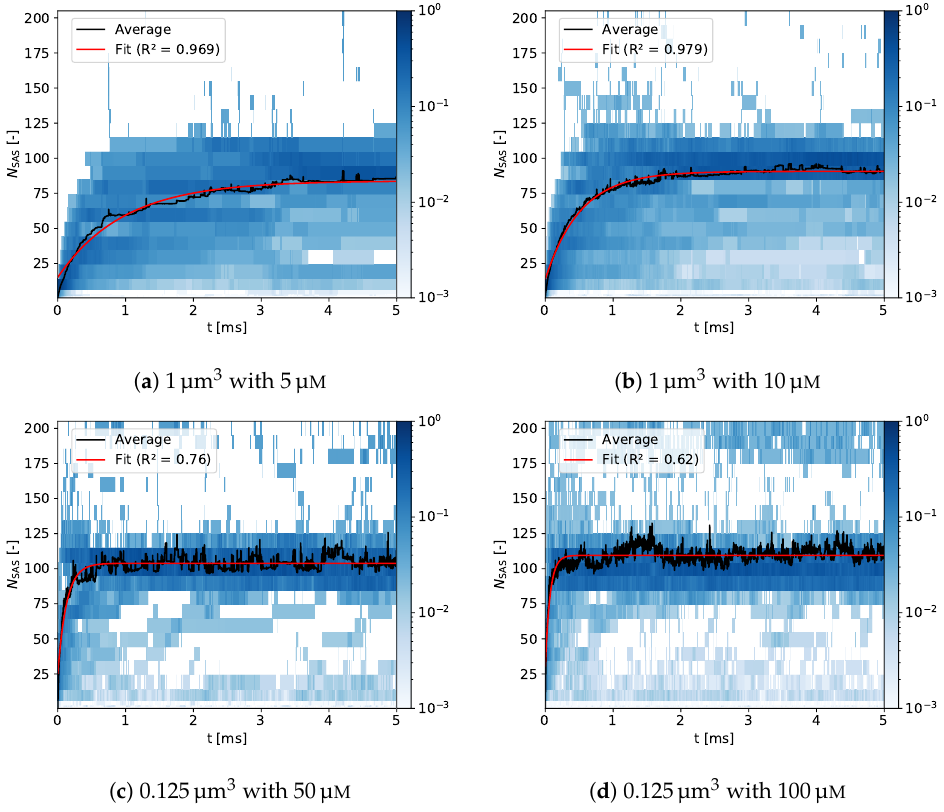
Figure 15. Histogram of self-assembled structures by number of constituting HBcAg 2 ( N SAS ) over time. τ SAS for concentrations in increasing order: 2.91, 1.55, 0.39, 0.21 ms. N SAS,asymp for concentra- tions in increasing order: 83.9, 90.7, 103.8,